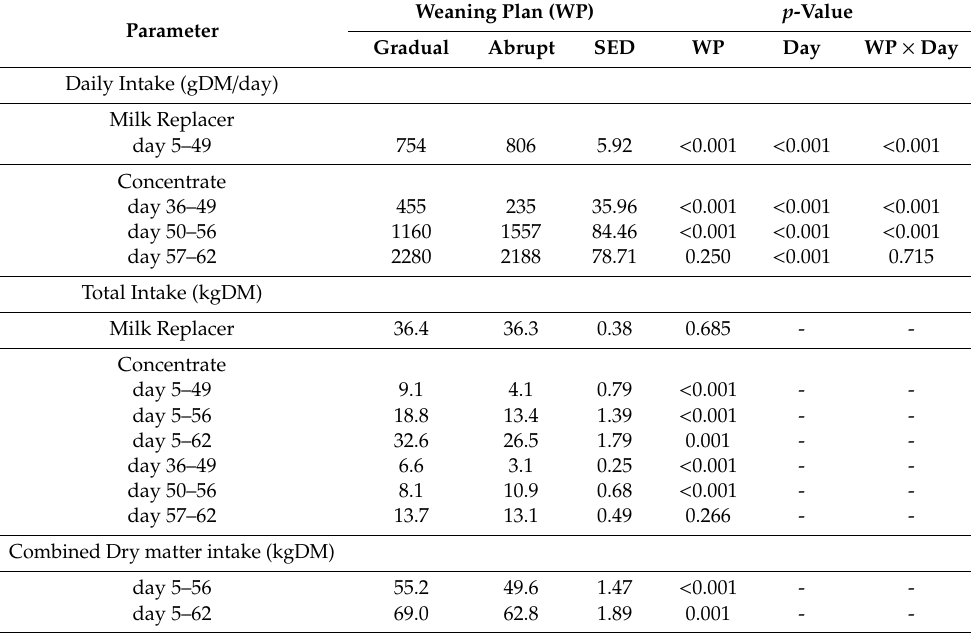
Table 3. Average daily and total intake of concentrate and milk replacer (on DM basis) of calves allocated to either a gradual or abrupt weaning